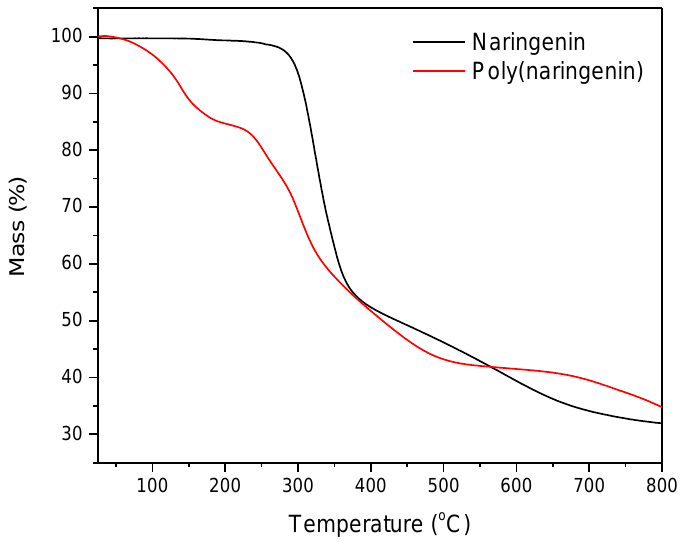
Figure 7. TG curves of naringenin and poly(naringenin). Table 1. Values of T10, T50, and T60 of naringenin and poly(naringenin). Standard deviation: tem- perature ±0.7 °C.